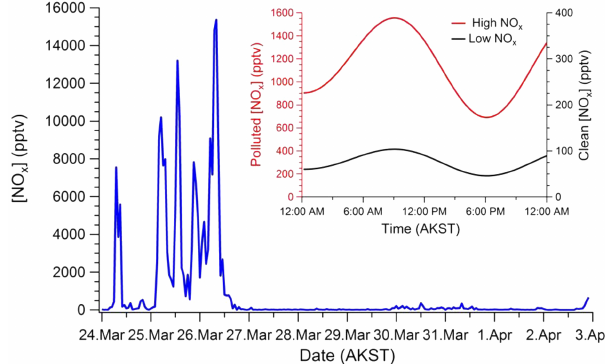
Figure 2. Observed (blue) NO x mixing ratios for the 10-day OA- SIS period in Barrow, AK, as well as model scenario diurnal NO x mixing ratios for low (black) and high (red)